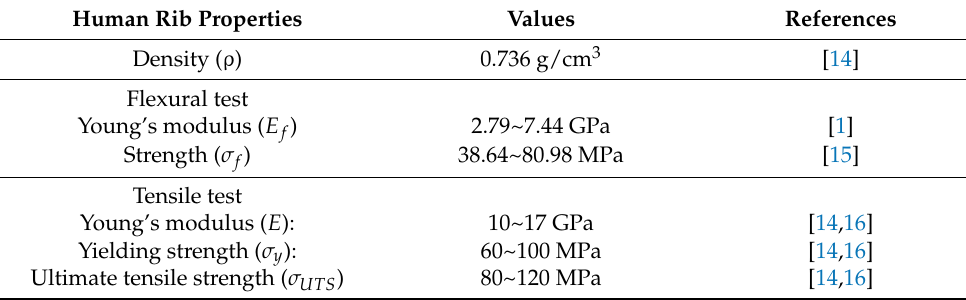
Table 1. The mechanical properties of a human rib. Human Rib